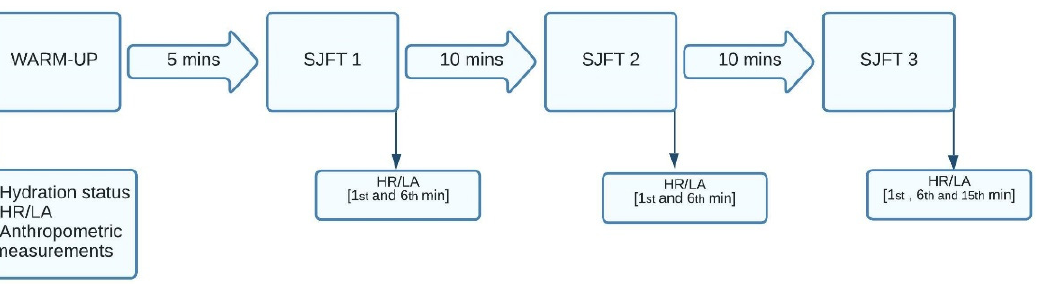
Figure 2. The performance test sequence. SJFT = special judo fitness test, HR = heart rate, LA = blood lactate.